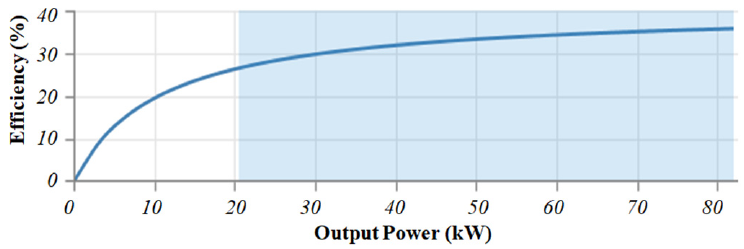
Figure 8. DG efficiency curve.